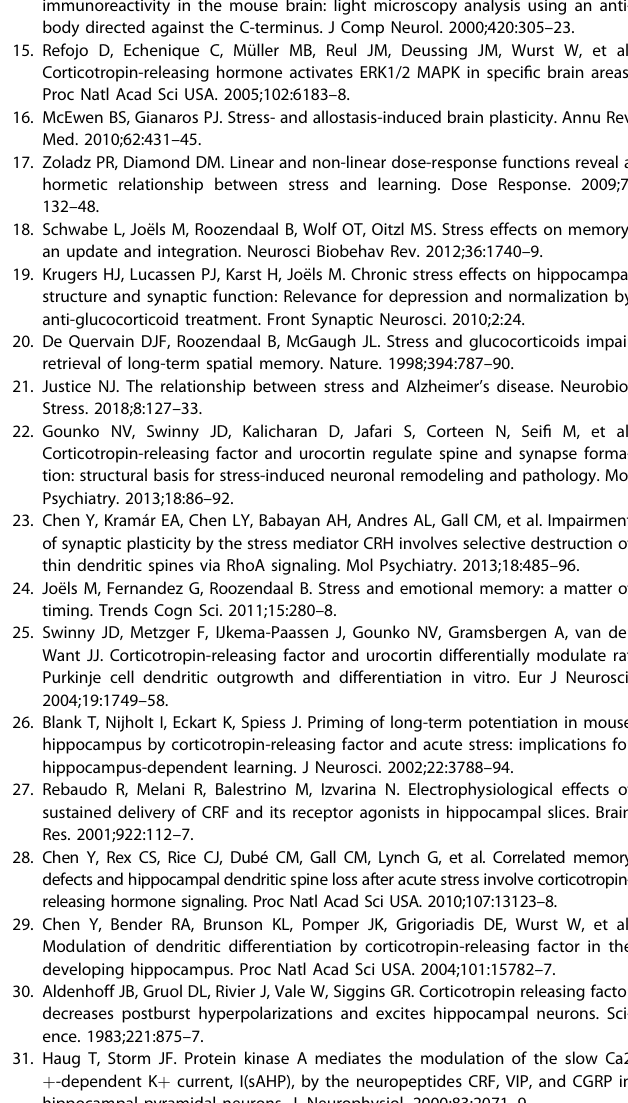
Fig. 5 Acute CRF alters multiple aspects of synaptic architecture. a TEM images from control (CTRL) and CRF-treated acute slices. Scale bar = 200 nm. b , c Quanti fi cation of presynaptic (PRE), ( b , shown as median with IQR. CTRL: N = 3 animals, n = 216 synapses; CRF: N = 3, n = 283; Mann – Whitney test (U = 30100). p = 0.7715), postsynaptic areas (spines, SP) ( c , shown as median with IQR. CTRL: N = 3, n = 219 synapses; CRF: N = 3, n = 304; Mann – Whitney test (U = 29456). * p < 0.05). d , e CRF (100 nM, 20 min) increased both the number of synapses per area ( d , shown as median with IQR. CTRL: N = 3, n = 177 areas; CRF: N = 3, n = 181; Mann – Whitney test (U = 10819). **** p < 0.0001) and e the number of multiple postsynaptic boutons per single presynapse. f , g CRF increased the total number of vesicles per synapse ( f , shown as median with IQR. CTRL: N = 3, n = 220 synapses; CRF: N = 3, n = 305; Mann – Whitney test (U = 18748). **** p < 0.0001), and g reorganized synaptic vesicles towards the active zone (AZ). h TEM images of PTA-stained synapses. Scale bar = 100 nm. i – k CRF increased AZ length ( i , shown as median with IQR. CTRL: N = 3, n = 452 synapses; CRF: N = 3, n = 771; Mann – Whitney test (U = 147985). **** p < 0.0001) and the number of PSD per area ( k , shown as median with IQR. CTRL: N = 3, n = 150 areas; CRF: N = 3, n = 150; Mann – Whitney test (U = 3736). **** p < 0.0001), but not postsynaptic density (PSD) length ( j , shown as median with IQR. CTRL: N = 3, n = 452 synapses; CRF: N = 3, n = 771; Mann – Whitney test (U = 167545). p = 0.2610). l Relationships between AZ and PSD at the synapse. The upper right represents an idealized, matched synapse,